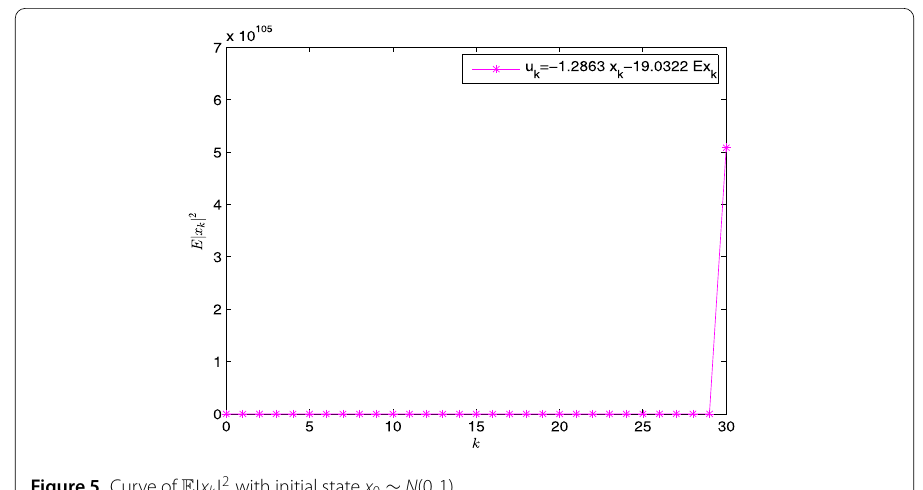
Figure 5 Curve of E | x k | 2 with initial state x 0 ∼ N